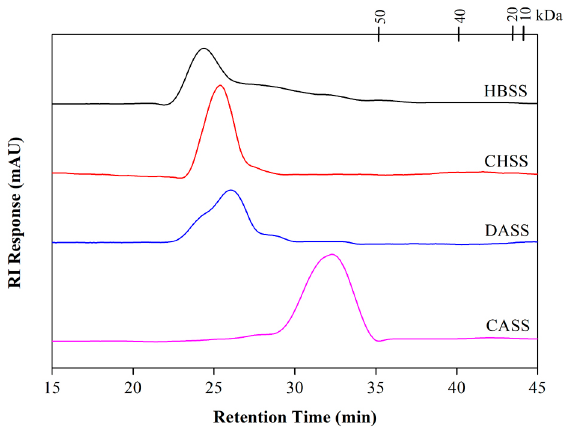
Figure 2. High-performance liquid chromatogram of MLPs. Table 2. The molecular weight and monosaccharide compositions of polysaccharides fractions. Rha: Rhamnose; Ara: Arabinose; Xyl: Xylos; Man: Mannose; Glu: Glucose; Gal: Galactose.